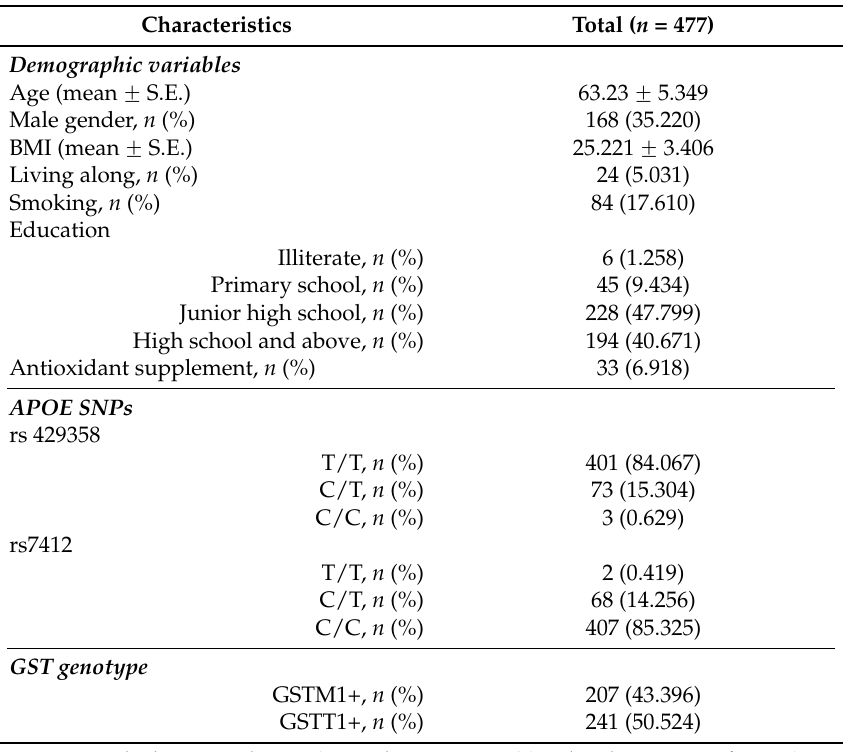
Table 1. Demographic characteristics of the